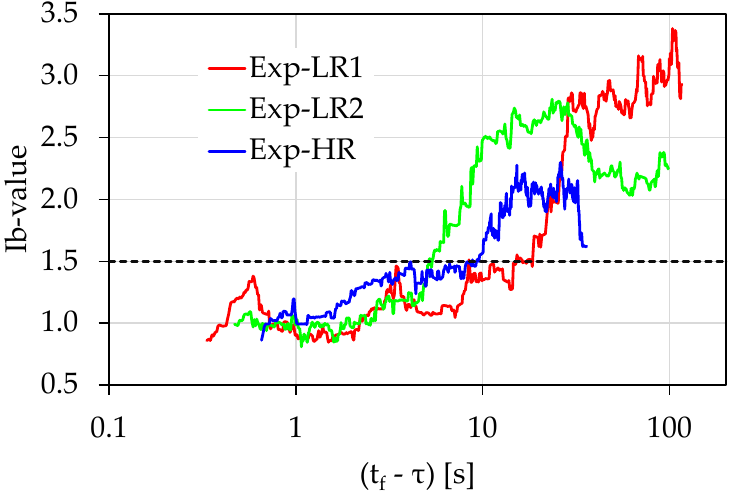
Figure 14. Comparative presentation of the temporal evolution of the Ib -values in juxtaposition to the load applied for the all the experiments in terms of the “time-to-failure” parameter.